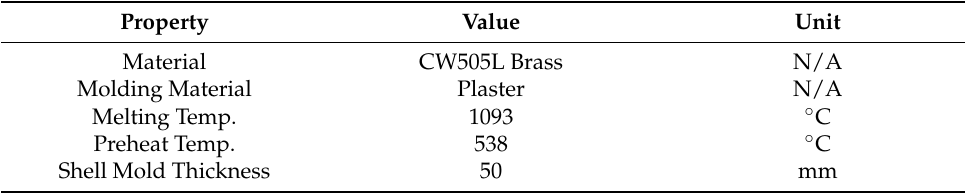
Table 1. Mold flow Altair Inspire Cast 2019.3 material properties.